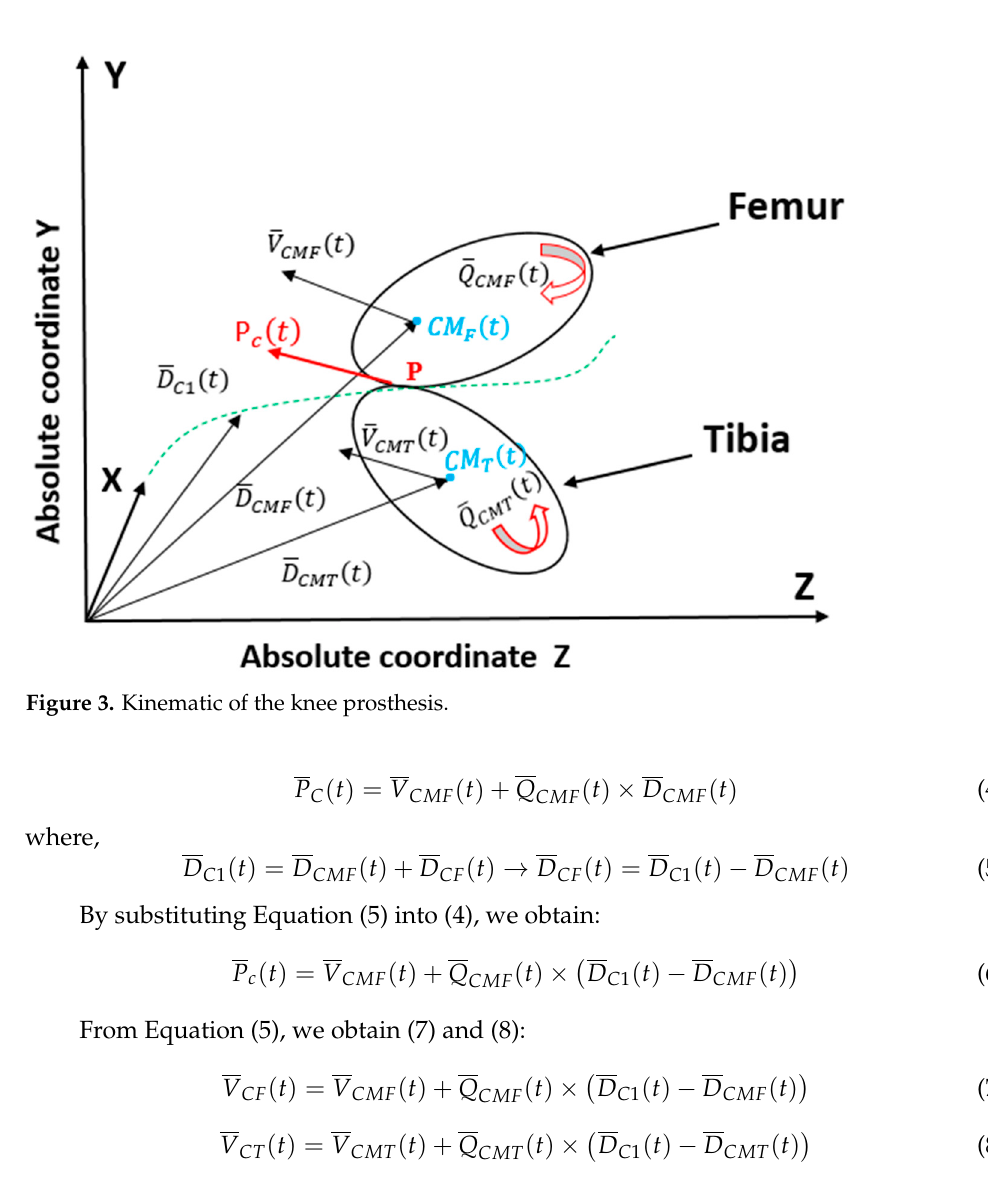
From Equation (5), we obtain (7) and (8):